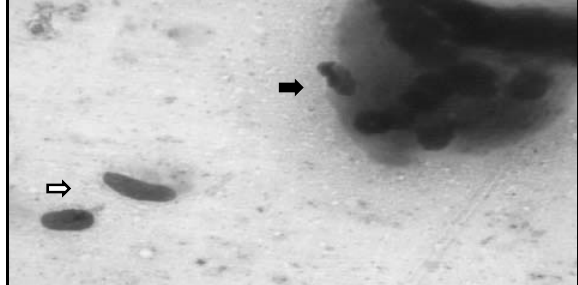
Figura 2 – Detalhe mostrando fibroblastos com núcleos ovalados e volumosos (seta branca) e célula muscular multinucleada, com citoplasma amplo (seta preta) (Giemsa,